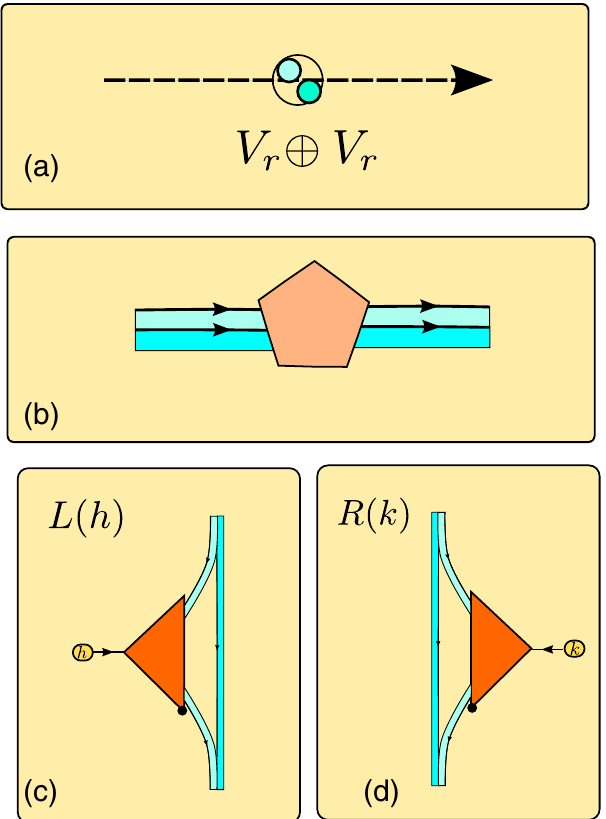
FIG. 16. (a) Gauge boson constituents in gauge magnets are ⊕ V states of the direct sum of two irreps V , which can be r r identified as the left and the right constituents at the ends of each link. Graphically, we represent this local Hilbert space as a single circle embracing the two copies of V , each of them being a r smaller circle identified by a different color and position inside the bigger circle. (b) The legs of the tensors acting on this Hilbert space are represented by bands rather than lines so that we can specify operators that only act on one sector as acting on half of the band. Each subsector is colored differently. (c),(d) The left and right rotations in the gauge magnets only act on half of the direct sum, as depicted here and discussed in Eq. (35).